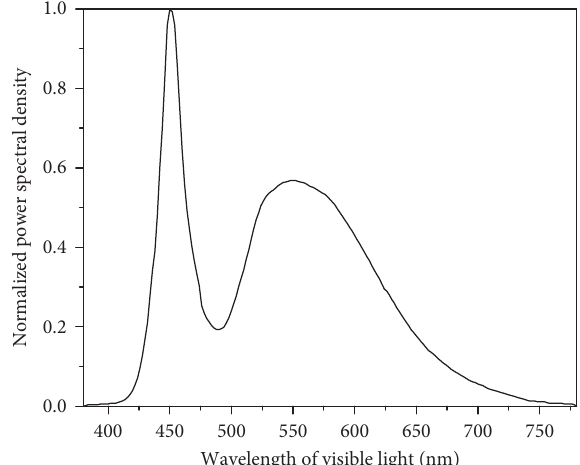
Figure 8: Normalized power spectral density of LEDs.